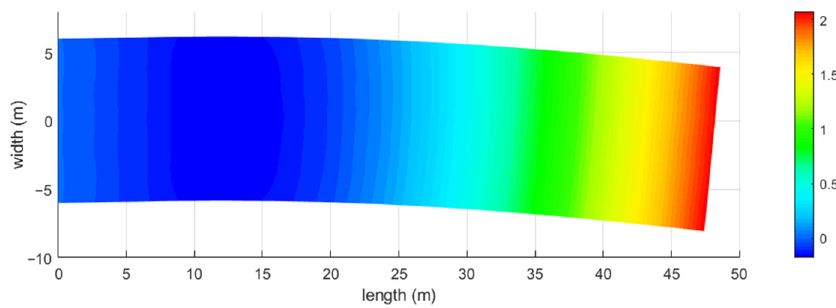
Figure 19. Vertical displacement field of the cantilever beam ( c = 1 Ns/m, t = 0.020 s), under Heaviside step loading with an infinite duration.